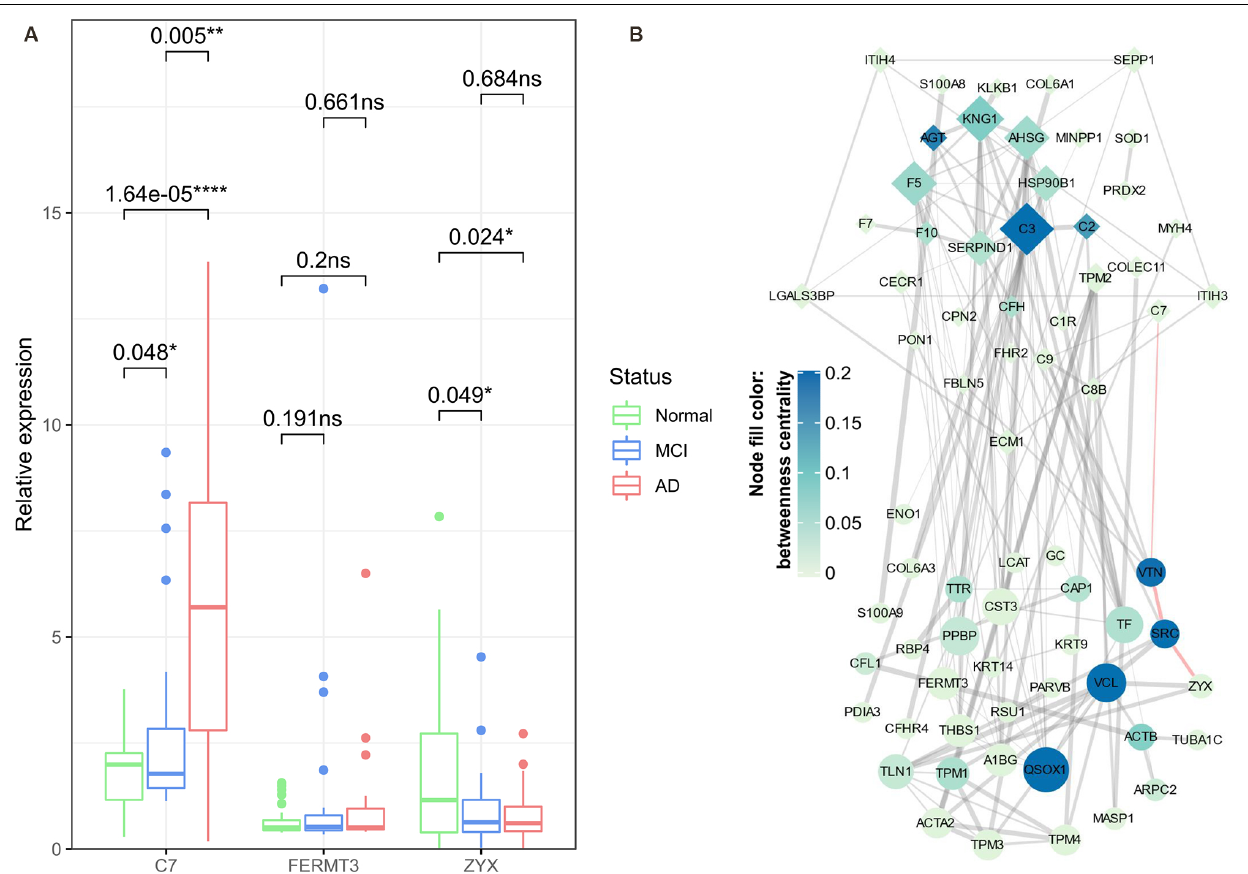
FIGURE 9 | ELISA validation of key proteins and construction of protein-protein interaction (PPI) network. Box and Whisker plot (A) demonstrate the median expression (middle line), minimum/maximum expression (whiskers) of key proteins (C7, FERMT3, and ZYX) validated in an independent set of samples using ELISA assay; the outliers are shown as colored dots. The statistical significance of t -tests between any two groups of samples is indicated by p -values and asterisks (* p < 0.05, ** p < 0.01, **** p < 0.0001). The PPI network (B) is constructed based on Cluster 4/Cluster 5 bridge proteins (denoted by diamond/oval-shaped nodes). The node size is proportional to the degree centrality of a node, whereas the color gradient represents the betweenness centrality of a node. The width of edges corresponds to the strength of the evidence supporting the connection between two nodes; the red-highlighted edges indicate a potential C7-VTN-SRC-ZYX cascade in the progression of AD. ns,